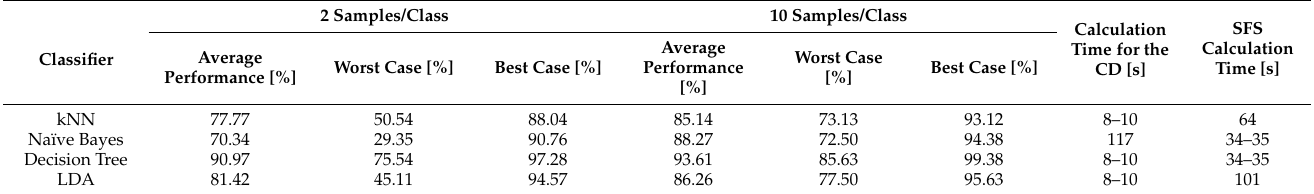
Figure 15. Calculation times for each classifier. Table 2. Comparison of different classifiers and their performance with CD and the calculation time for feature selection.